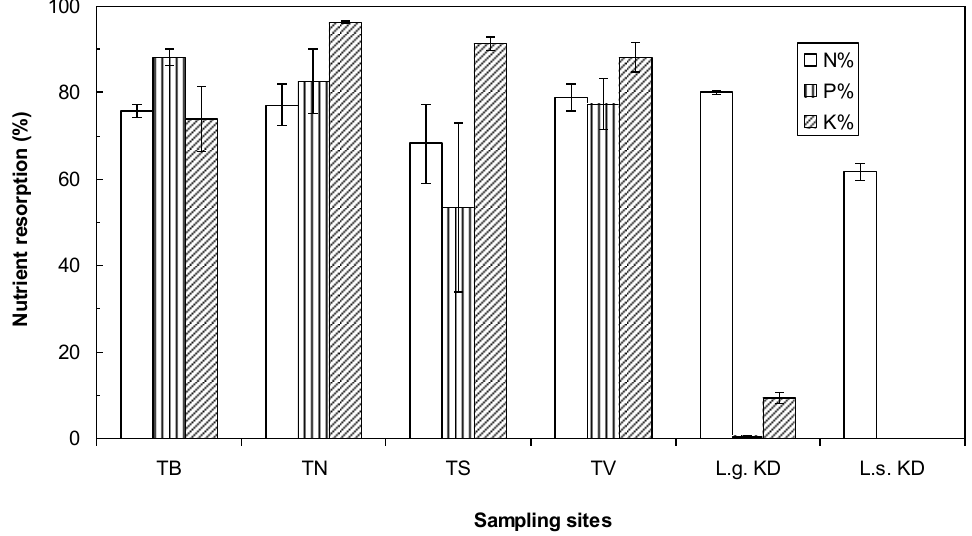
Figure 5. Intra- and inter-species variation of nutrient resorption efficiency of larch species from permafrost-affected (Tura) and permafrost-free (Krasnoyarsk) sites. Resorption of P and K is not available for L. sibirica (L.s. KD) as these elemental concentrations were not measured in senesced needles. Means and standard deviation of three replicates.